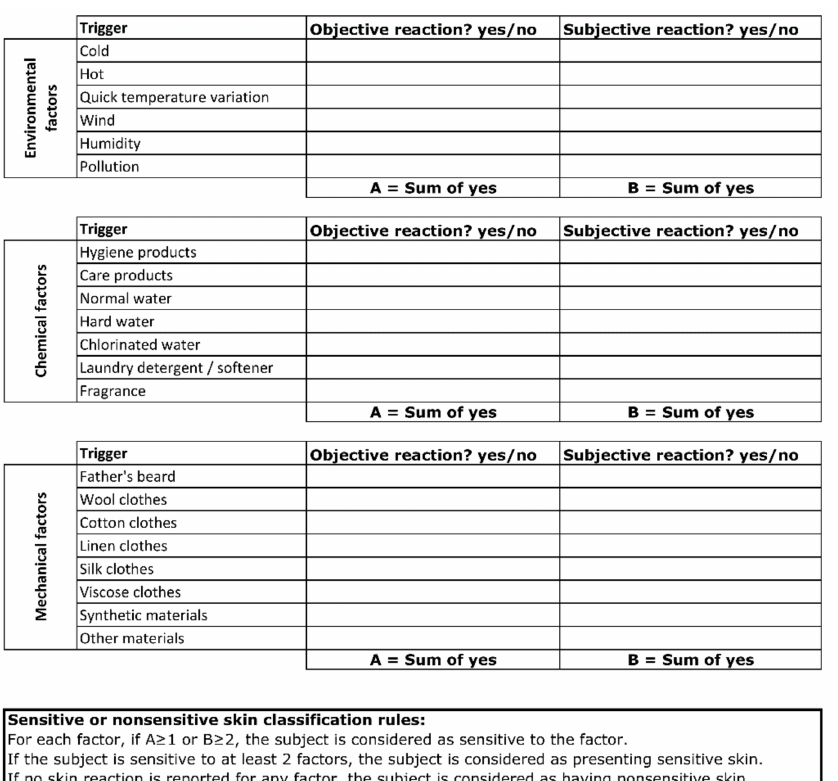
Figure 1. Questionnaire for the identification of children with sensitive or nonsensitive